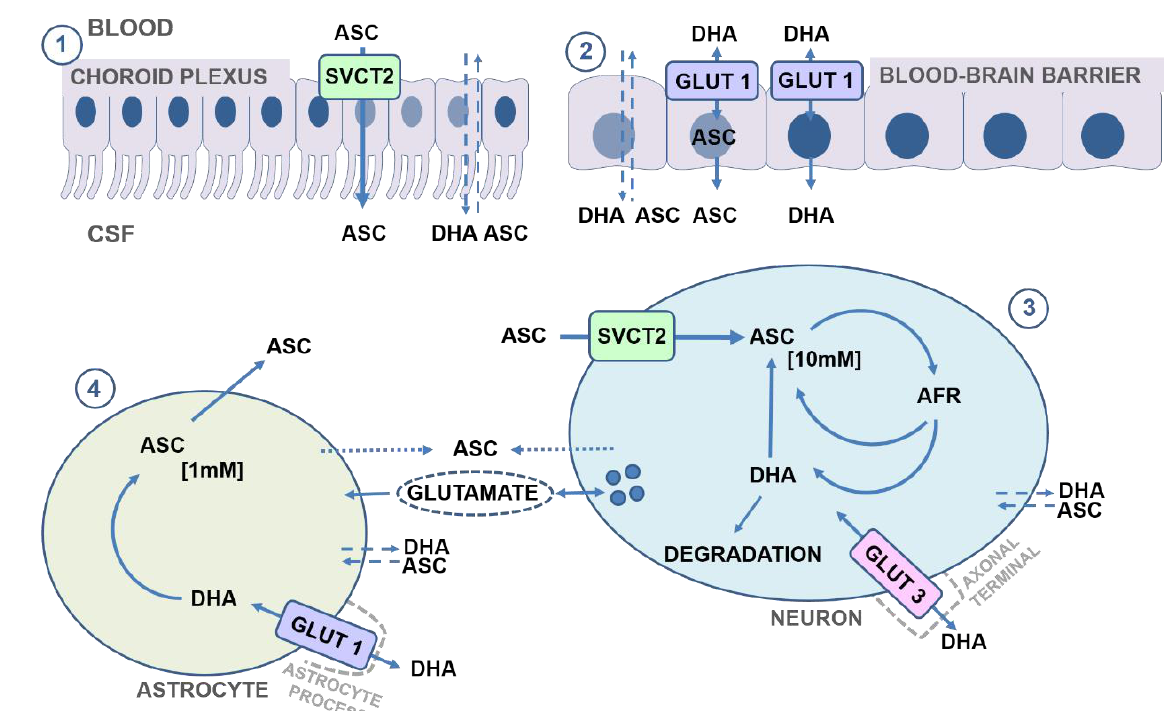
Figure 3. Schematic overview of mechanisms of vitamin C uptake and recycling in the brain. ( 1 ) Vitamin C (vitC) primarily enters the brain either by SVCT2-mediated ascorbate (ASC) transport through the epithelial cells of the choroid plexus to the cerebrospinal fluid (CSF), or as dehydroascorbic acid (DHA) via glucose transporter 1 (GLUT1) situated on the blood–brain barrier (BBB) endothelia ( 2 ). DHA may be recycled to ASC within the BBB-endothelial cells or released directly to the extracellular matrix. Passive diffusion of ASC and DHA may also occur; however, efflux mechanisms regulating vitC release are yet largely unaccounted for. ( 3 ) Extracellular ASC mainly enters neurons through SVCT2 transporters. Intracellularly, ASC may be oxidized leading to formation of the ascorbate free radical (AFR). AFR can then form ASC and DHA. DHA may be recycled to ASC through reduction, be transported out of the neuron e.g., by diffusion, or cleared (degraded). Neurons also possess GLUT3 transporters, allowing for facilitated diffusion of DHA. Together, these mechanisms enable the increase in concentration of high intracellular ASC in neurons, reaching as much as 10 μM. ASC may be released from neurons in response to glutamate uptake. ( 4 ) Astrocytes do not express SVCT transporters but can take up DHA through GLUT1 facilitated diffusion. DHA is recycled to ASC maintaining a concentration gradient across the astrocyte plasma membrane and promoting the continued DHA uptake and enabling the increase in concentration of intracellular ASC. ASC can then be released from the astrocytes to the extracellular matrix for subsequent uptake to neurons. This can be, e.g., in conjunction with neuronal glutamate release, where glutamate uptake and clearance by astrocytes prompts the release of ASC. AFR: Ascorbate free radical; ASC: Ascorbate; BBB: Blood–brain barrier; CSF: Cerebrospinal fluid; DHA: dehydroascorbic acid; GLUT: glucose transporter; SVCT: sodium coupled vitamin C co-transporter; VitC: vitamin C.